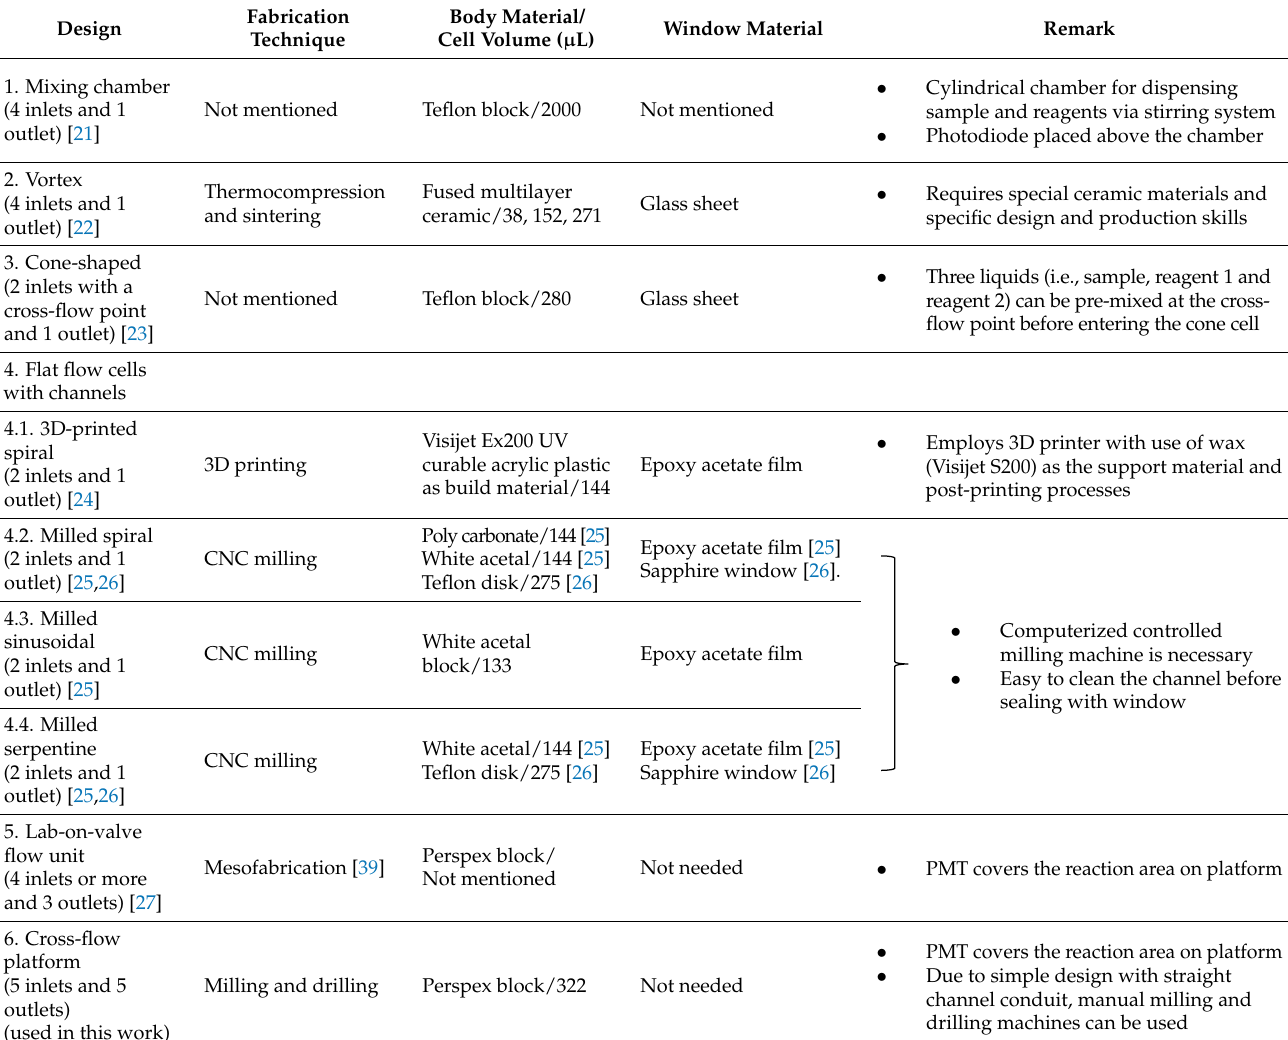
Table 2. Comparison of chemiluminescence flow cells with built-in ports for sample or reagent(s) introduction and an outlet on the cell